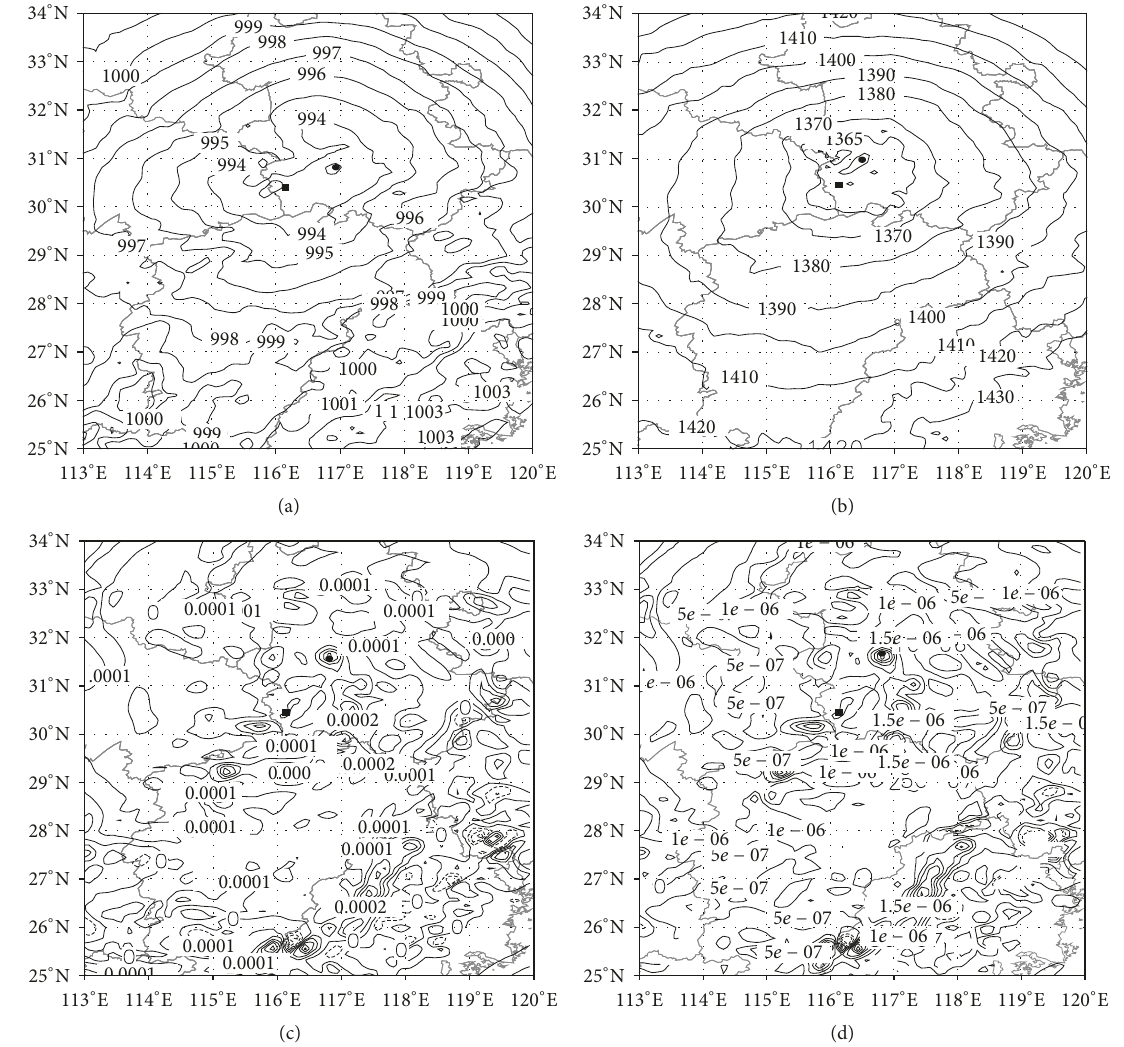
Figure 1: The sea level surface pressure ((a), hPa), 850 hPa geopotential height ((b), gpm), relative vorticity ((c), s −1 ), and potential height ((d), m 2 ⋅ K ⋅ s −1 ⋅ kg −1 ) simulated by WRF model at 1200 UTC 30 July 2008. The filled square represented the observed TC center and the filled circle indicated the point with minimum value (in (a) and (b)) or maximum value (in (c) and (d)) around observed TC